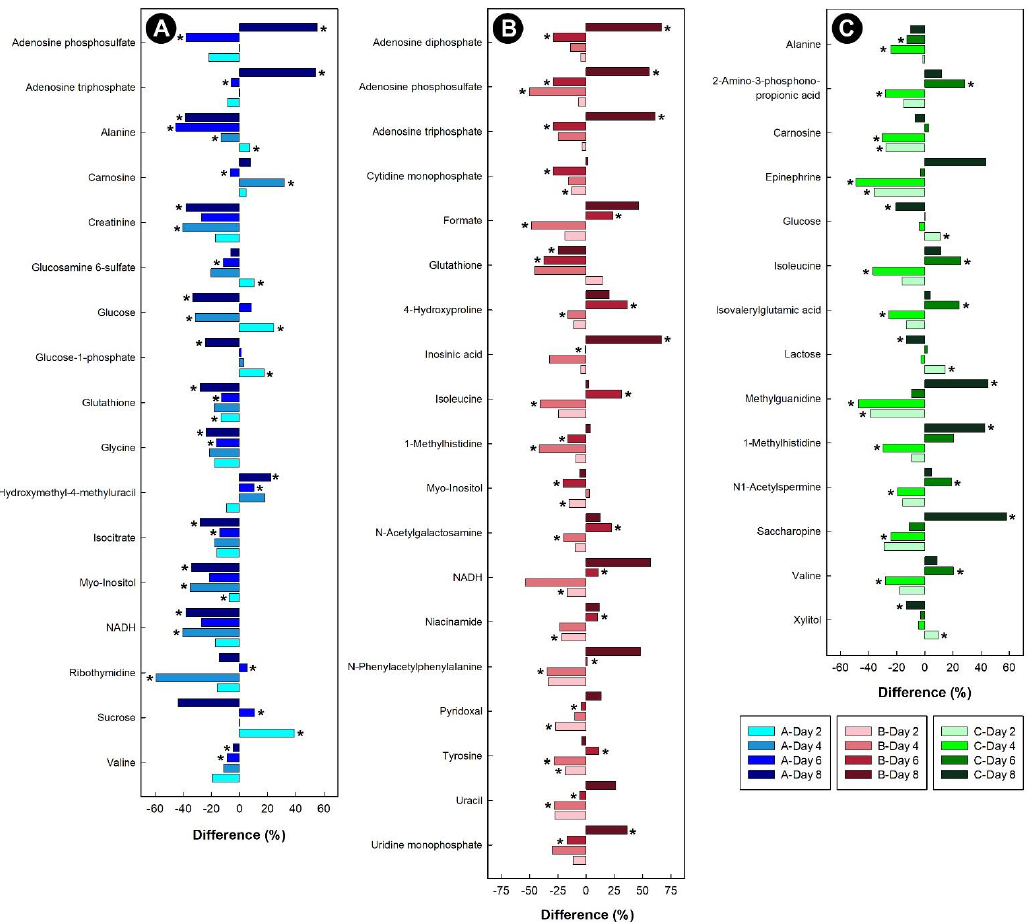
Figure 9. Regulation of common metabolites in the livers of broiler chicks subjected to stressors relative to control treatment at the four experimental endpoints. ( A ) Corticosterone (blue); ( B ) heat (red); and ( C ) isolation (green). Metabolites that were altered ( p < 0.050) are indicated by asterisks. For the kidney samples obtained from birds administered corticosterone, threonine, malate, anserine, acetylcholoine, acetylcarnitine, and 4-hydroxyproline were all down- regulated (Figure 10A). Glucose was the only metabolite to be up-regulated in chicks at all time-points. For the heat treatment, 1-methyladenosine was initially down-regulated in chicks, and then up-regulated after 8 days of heat treatment (Figure 10B). Isolation re- sulted in the down-regulation of threonine in chicks, while uracil was initially down-reg- ulated, and then up-regulated after 8 days in kidney tissue (Figure 10C).